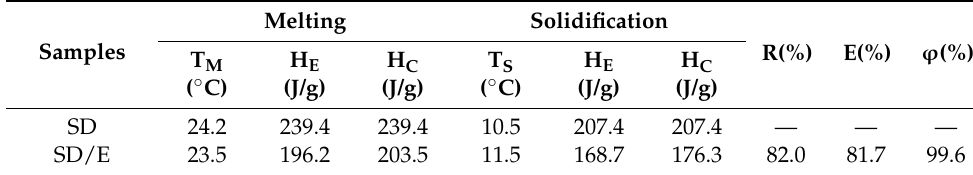
Figure 4. DSC curves of SD and SD/E. Table 1. Phase change parameters of SD and SD/E.